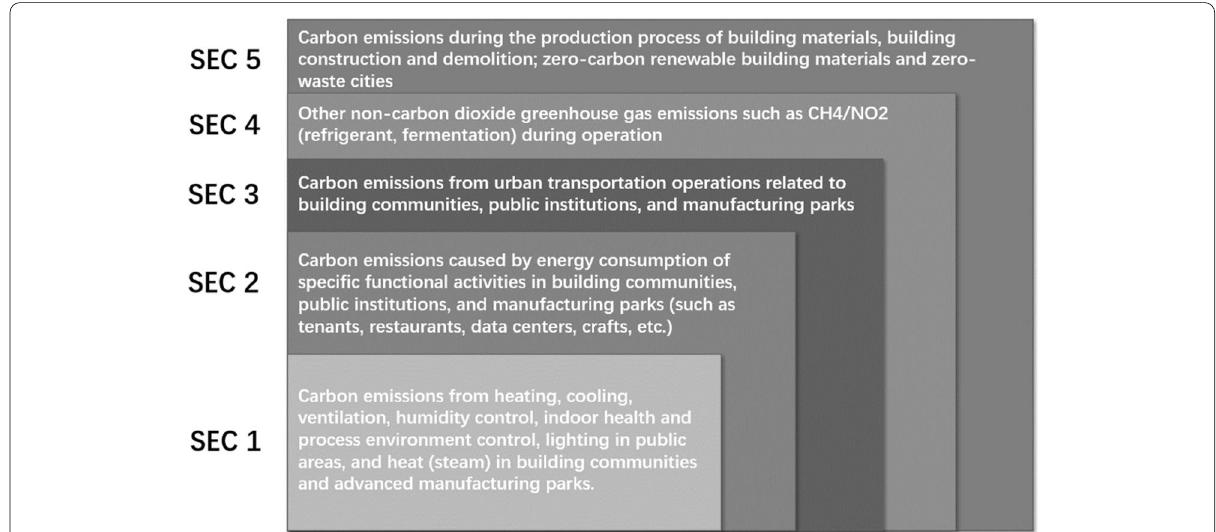
Fig. 2 Implementation boundaries of decarbonization actions in the public building sector